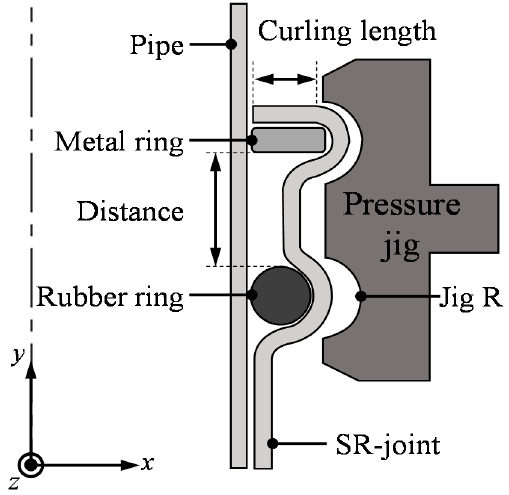
Figure 8. Design variables of the proposed SR-joint (SR-II).